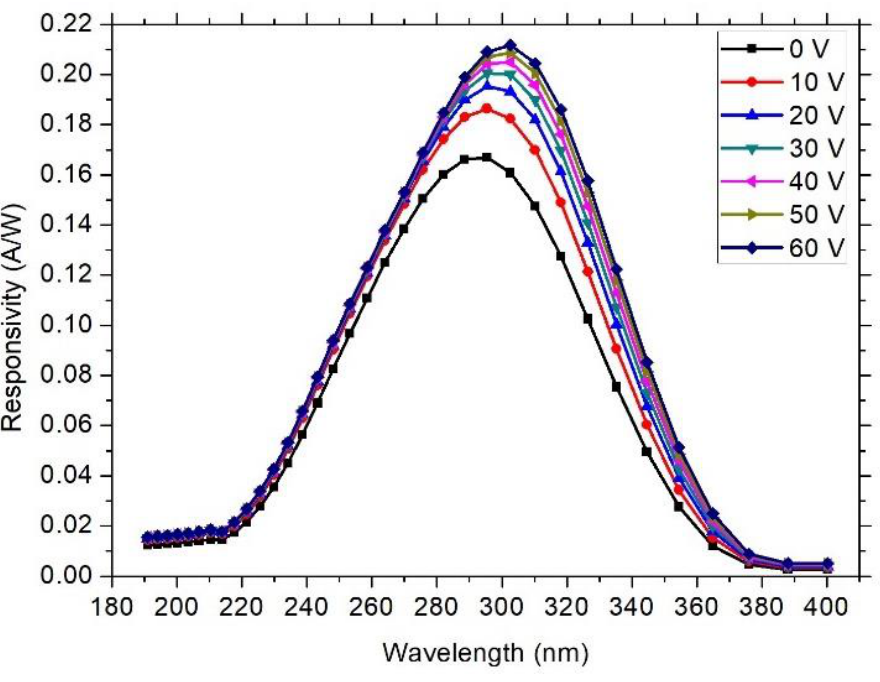
Figure 6. 4H − SiC UV p − i − n photodiode simulated spectral responsivities under different reverse biases, from 0 V to 60 V. A red − shift of about 6 nm of the responsivity peak wavelength is evident. From Table 4, the responsivity peak increases from R = 0.168 A/W at 0 V to R = 0.212 A/W at 60 V. This last value corresponds to an EQE = 87.9%. Table 4. Responsivities and external quantum efficiencies for different bias conditions for both experimental and simulation results.